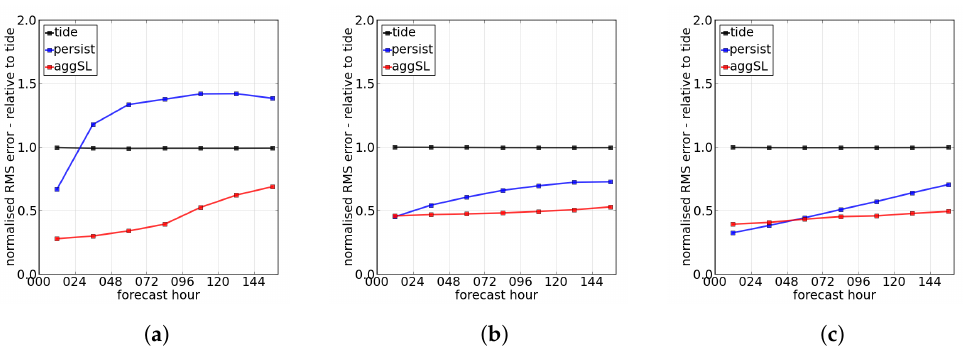
Figure 7. Relative error metrics at select locations as per Figure 6. RMSE at increasing forecast lead times is normalised and plotted relative to the standard tidal residual—such that a lower value represents greater accuracy. Error growth with forecast age is evident. ( a ) As per (a) in Figure 6; ( b ) As per (b) in Figure 6; ( c ) As per (c) in Figure